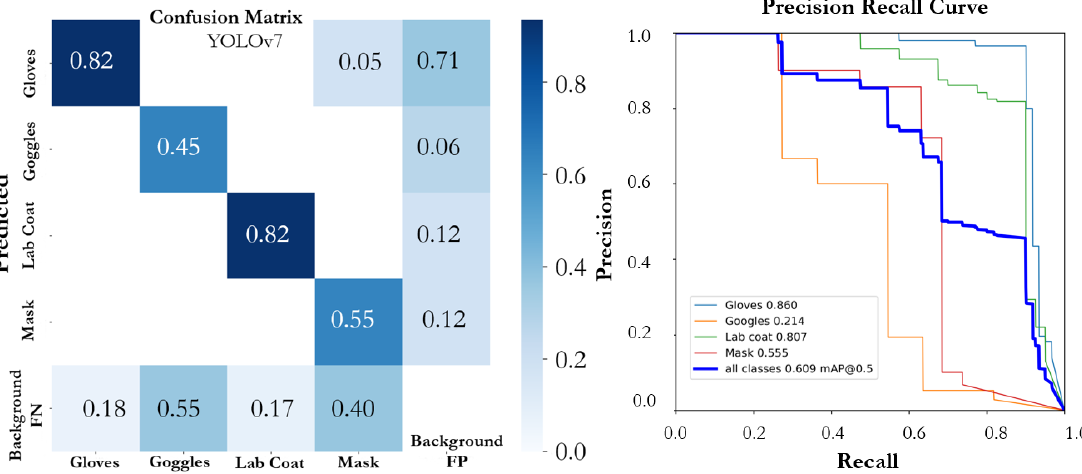
Figure 12. Confusion matrix and PR curve of the YOLOv5x model.